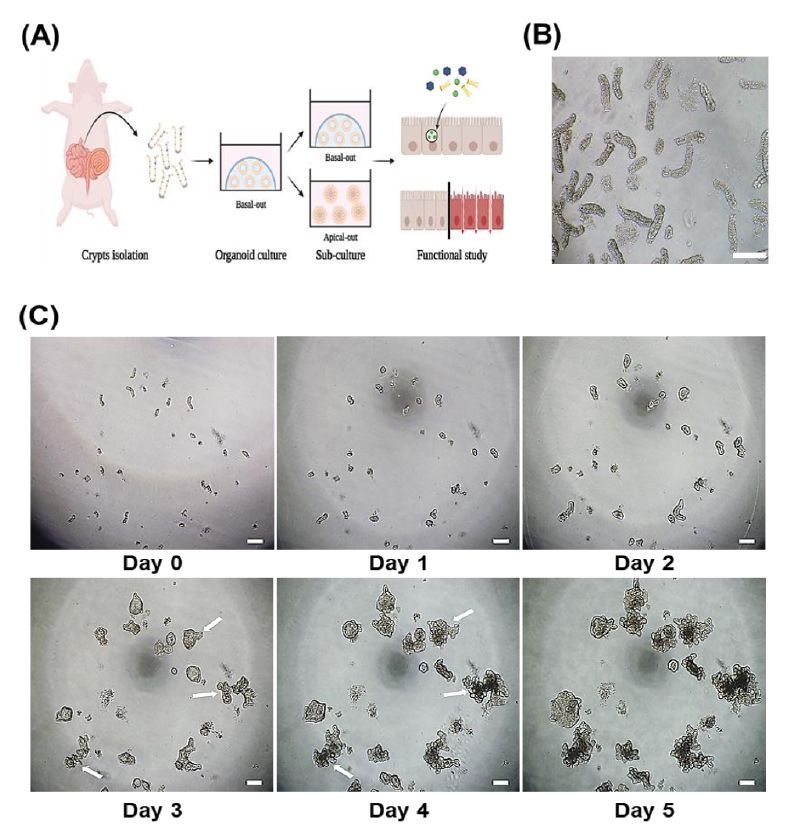
Figure 1. Development of small intestinal organoids in porcine jejunum tissue. ( A ) Brief scheme for experimental procedure of this study. ( B ) Representative image of isolated crypts from pig jejunum tissue (magnification: × 100). Scale bar (100 µ m). ( C ) The organoids images show development of organoids from day 0 to day 5 (magnification: × 40). The arrows indicate the organoid budding points. Scale bar (200 µ m).